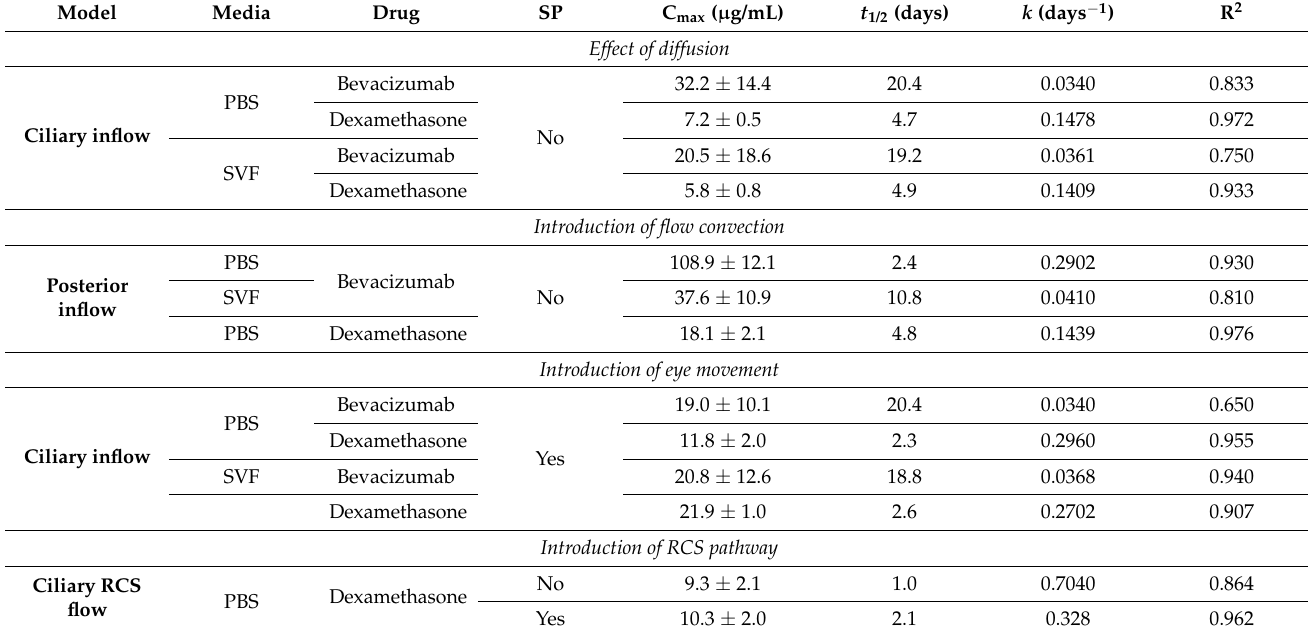
Table 2. Summary of the release kinetics of dexamethasone and bevacizumab using the ciliary inflow, posterior inflow, and ciliary RCS flow models with and without slow pursuit movement.